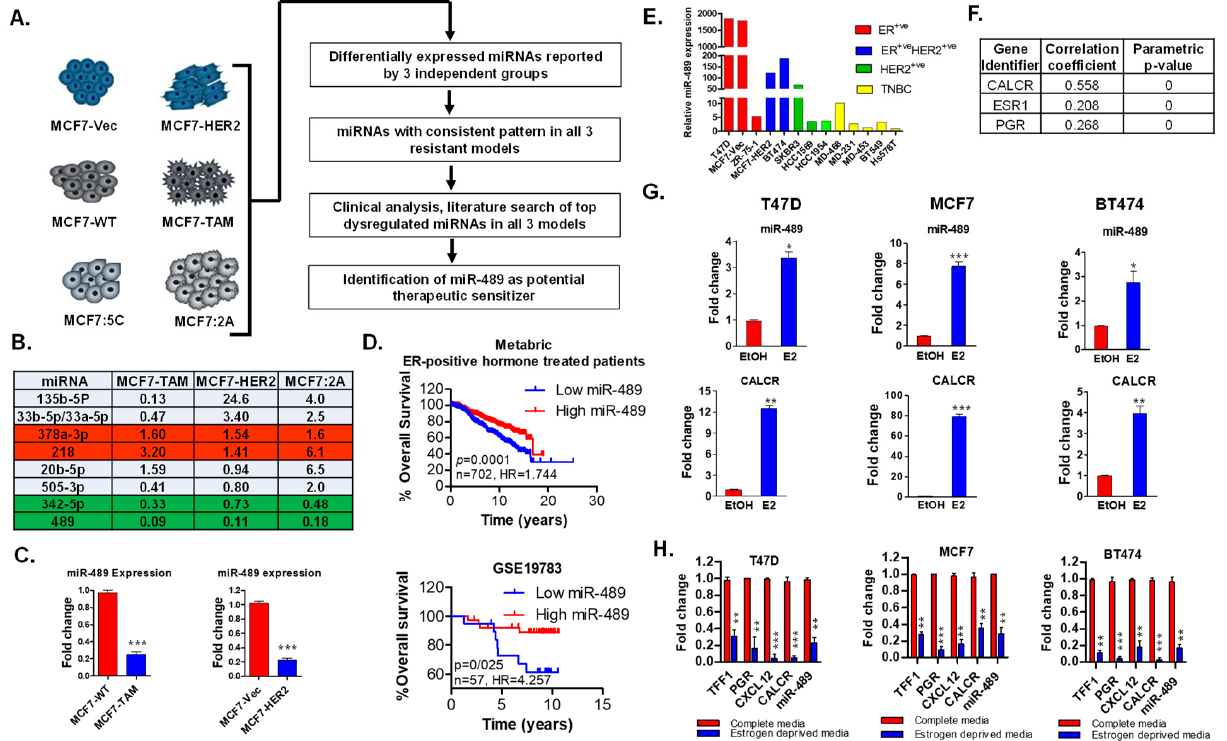
Figure 1. miR-489 expression is lost in tamoxifen resistance, predicts breast cancer aggressiveness, and is regulated by the estrogen/ER α axis. ( A ) Schematic diagram for the identification and validation of miRNAs involved in tamoxifen resistance. miRNA analysis from three independent studies using three independent tamoxifen-resistant model systems. ( B ) List of top dysregulated miRNAs in all three tamoxifen-resistant cell lines. ( C ). qRT-PCR validation of miR-489 in MCF7-TAM and MCF7-HER2 cell lines. ( D ) Clinical analysis of two datasets analyzing miR-489 expression in ER+ breast cancer patients receiving hormone therapy. ( E ) miR-489 expression in breast cancer cell lines. ( F ) Correlation of miR-489 expression with expression of ER α and PGR. ( G ) qRT-PCR analysis of miR-489 expression upon estrogen stimulation in three ER+ breast cancer cell lines. ( H ) qRT-PCR analysis of miR-489 expression upon estrogen deprivation in three ER+ breast cancer cell lines. * p < 0.05; ** p < 0.01; *** p < 0.001. Data are representative of three independent experiments.